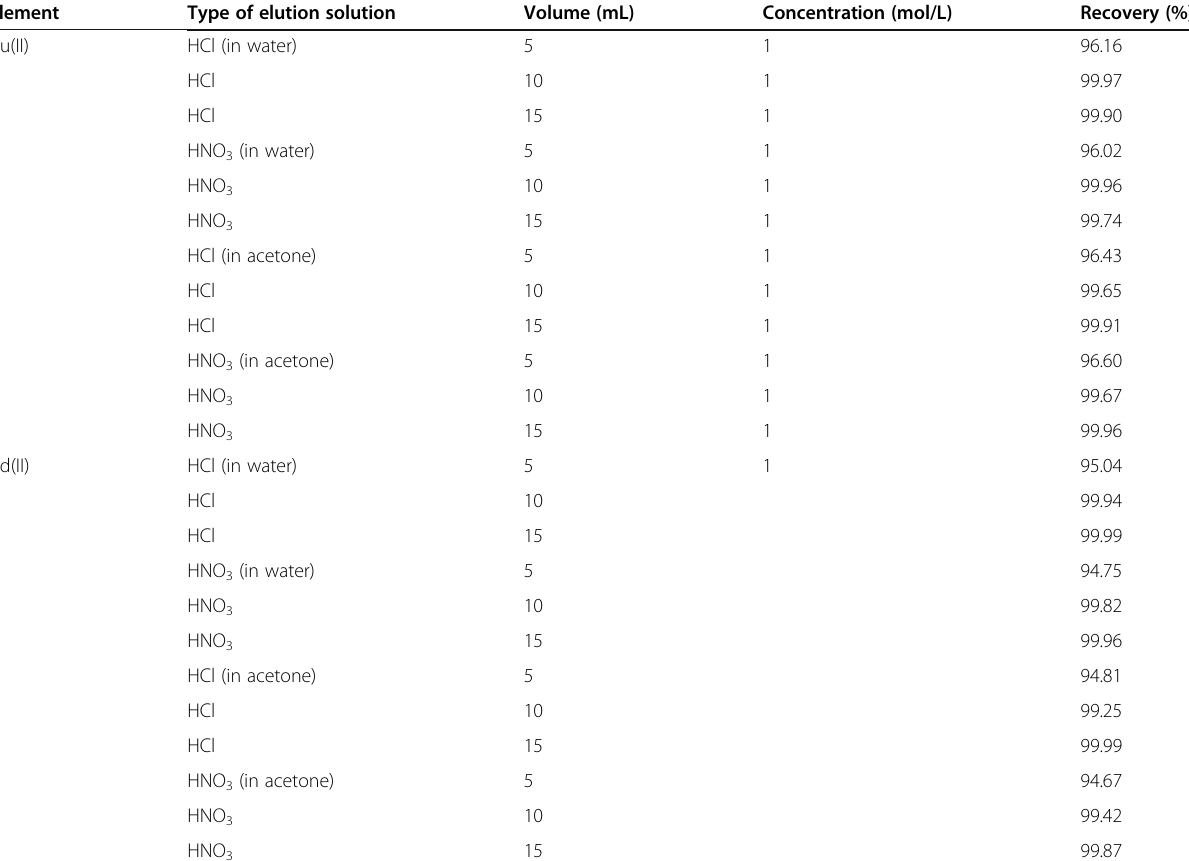
Table 3 Effect of the type and volume of elution solutions on the recovery of metals Element